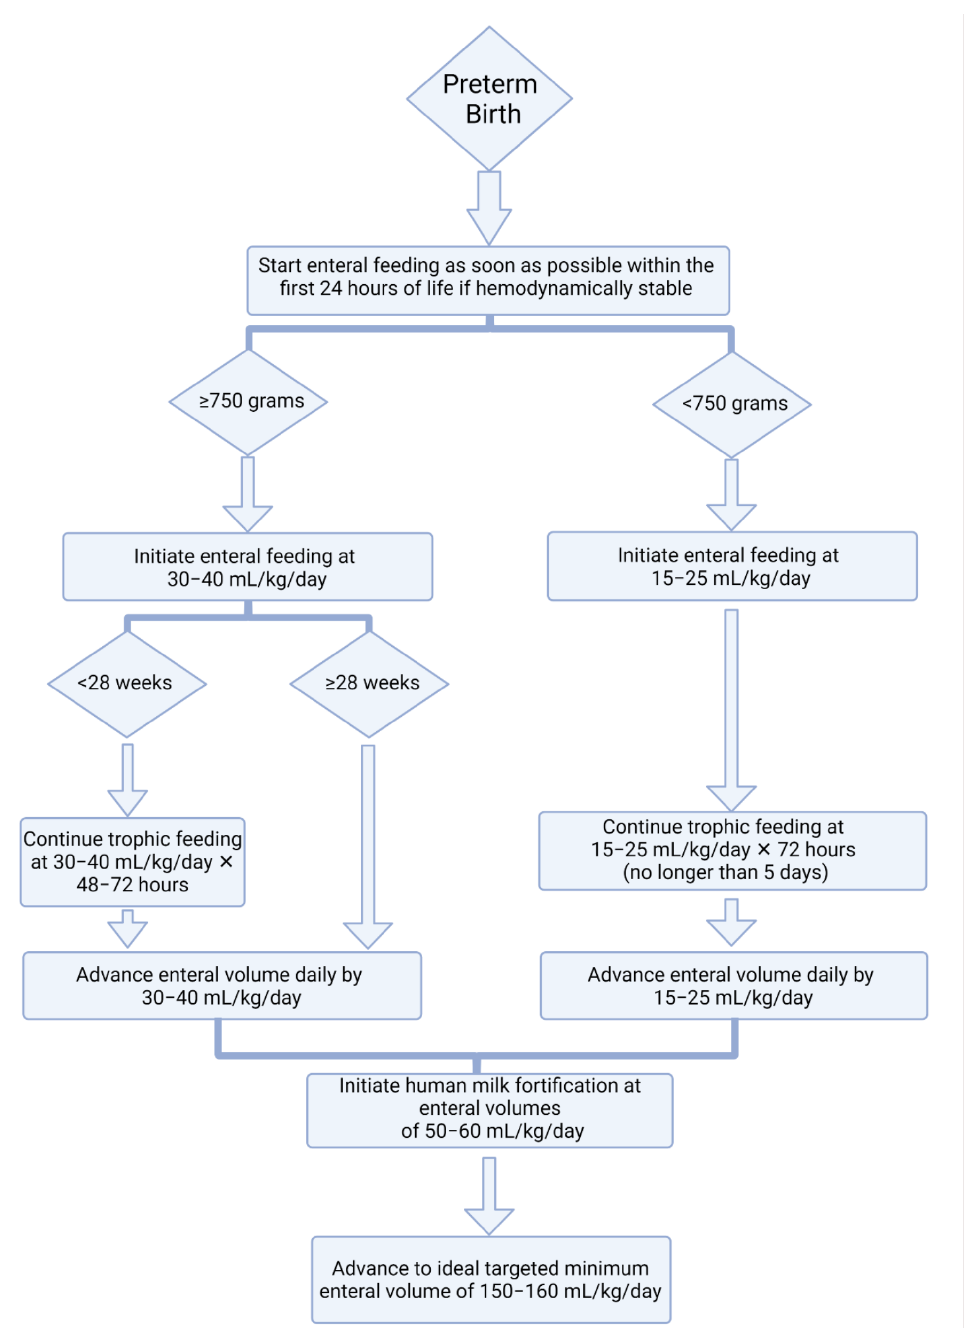
Figure 3. Proposed decision making for initiating and advancing enteral feeding in preterm